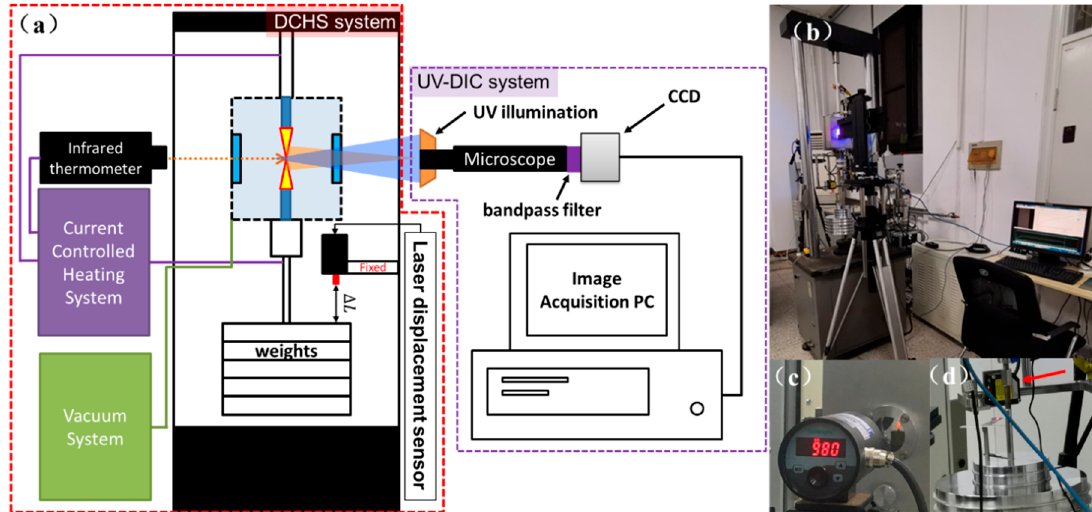
Figure 3. ( a ) The illustrations of direct current heating system (DCHS) and UV-digital image correlation (UV-DIC) system; ( b ) the application of DCHS during the creep test; ( c ) the colorimetric infrared thermometer shows that the creep temperature is 980 °C; ( d ) the laser displacement sensor (LDS) is measuring the distance between the weight surface and itself.